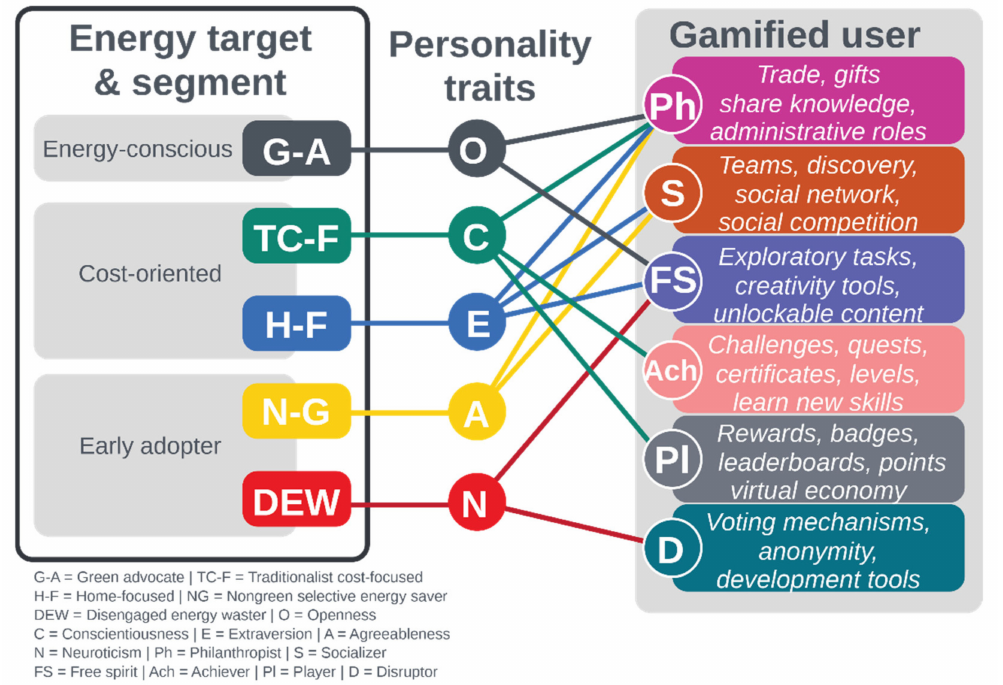
Figure 3. Personality traits as the central axis and their relationship with gamification and energy consumer